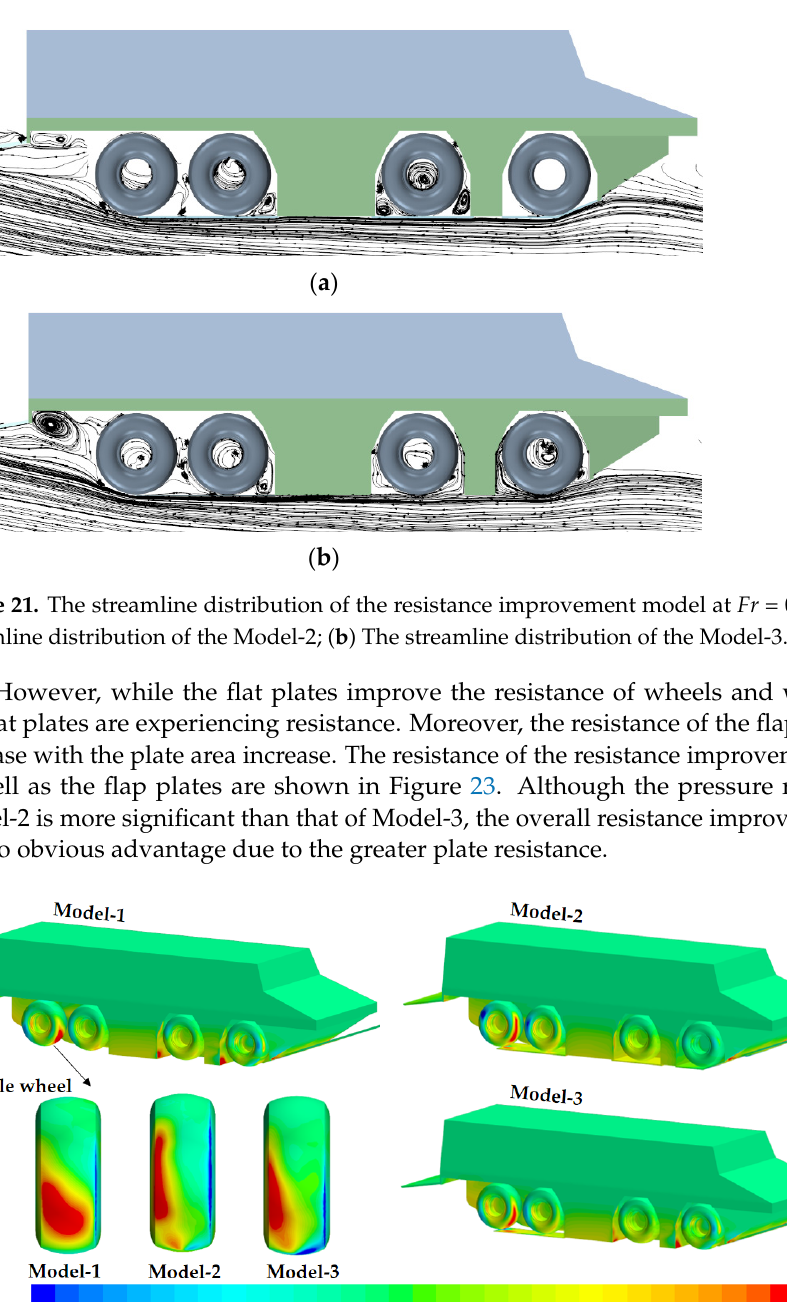
Figure 23. The resistance of the resistance improvement models and flap plates. ( a ) Total resistance of amphibious vehicles; ( b ) The resistance of the flat plates.